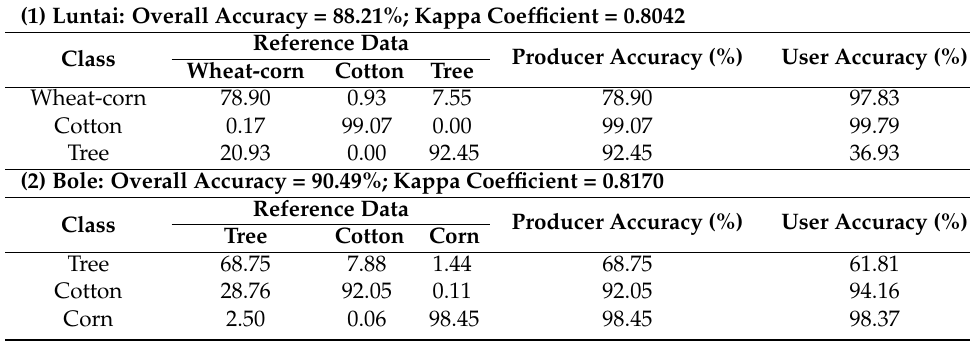
Table 12. Accuracy evaluations of (1) Luntai and (2)